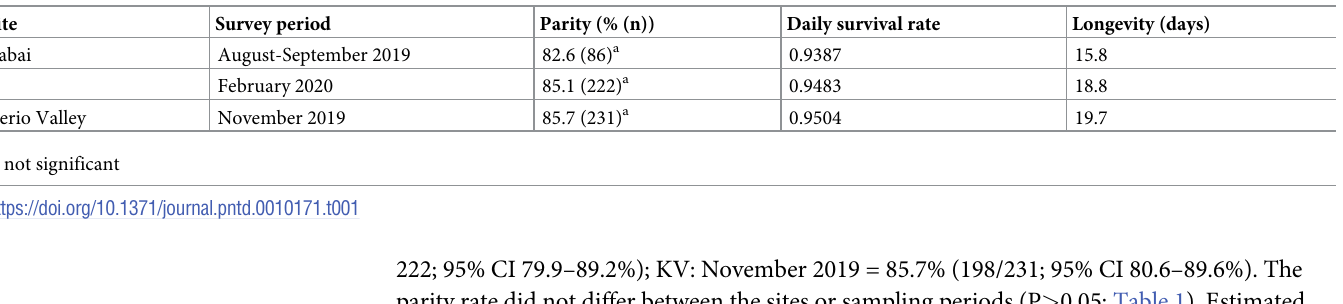
Table 1. Estimated parity, daily survival and age for Ae . simpsoni